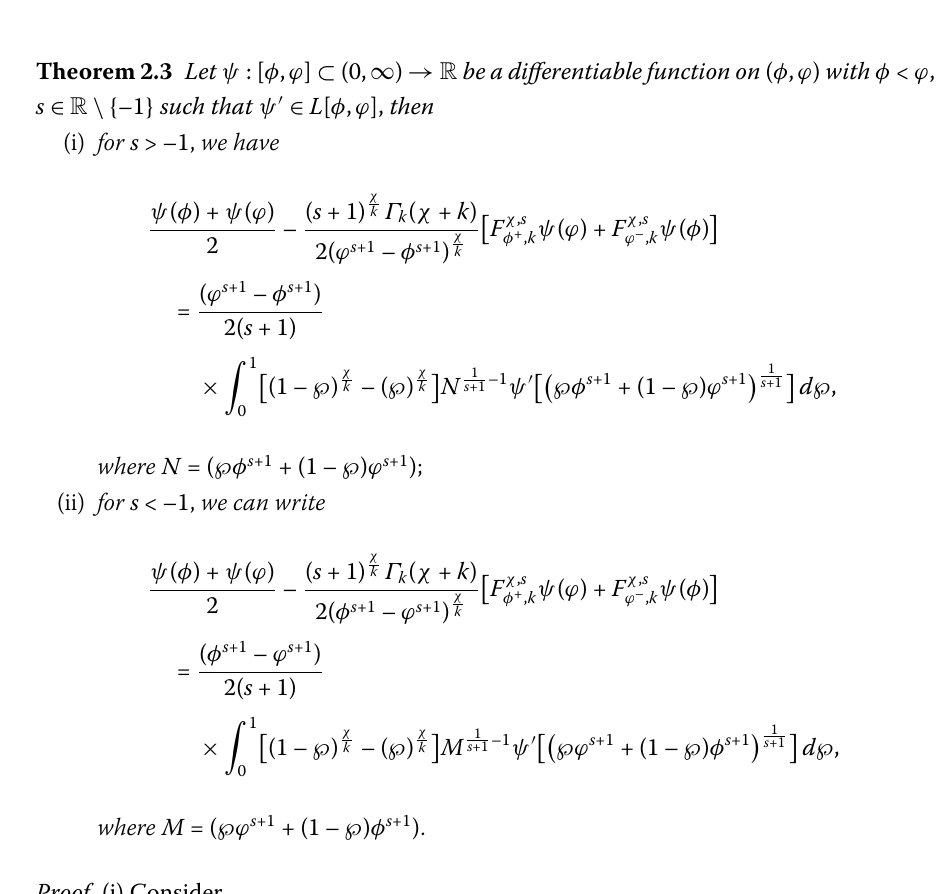
Figure 1 The graphs illustrate the validity of the double inequality (2.10) for the case φ = 0, ϕ = 1, and k =